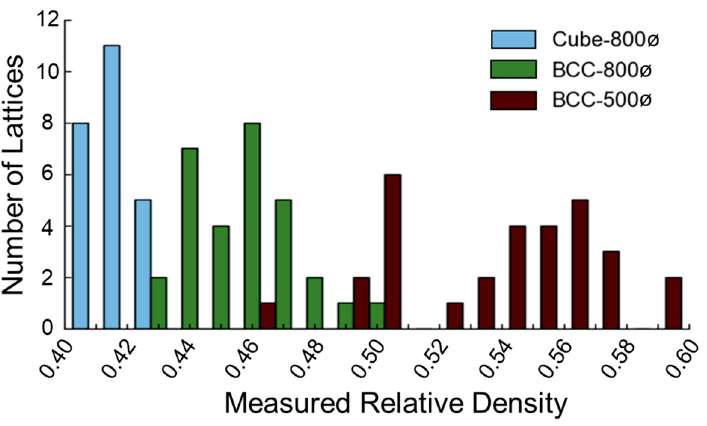
Figure 7. Histogram of measured relative density for thirty samples of each lattice design.